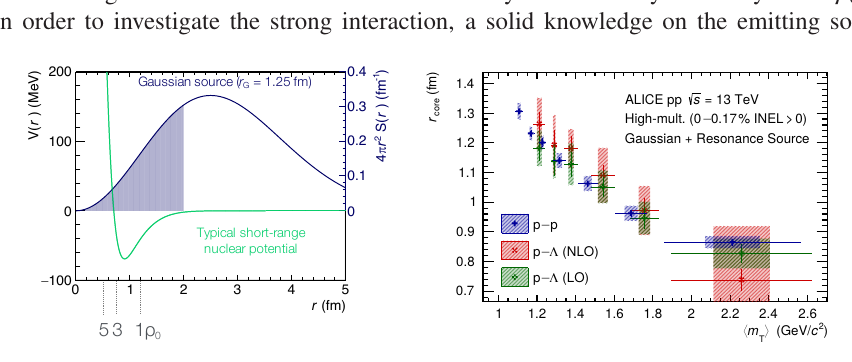
large amount of particle pairs with small k ∗ can be produced, as shown by the blue shaded area.